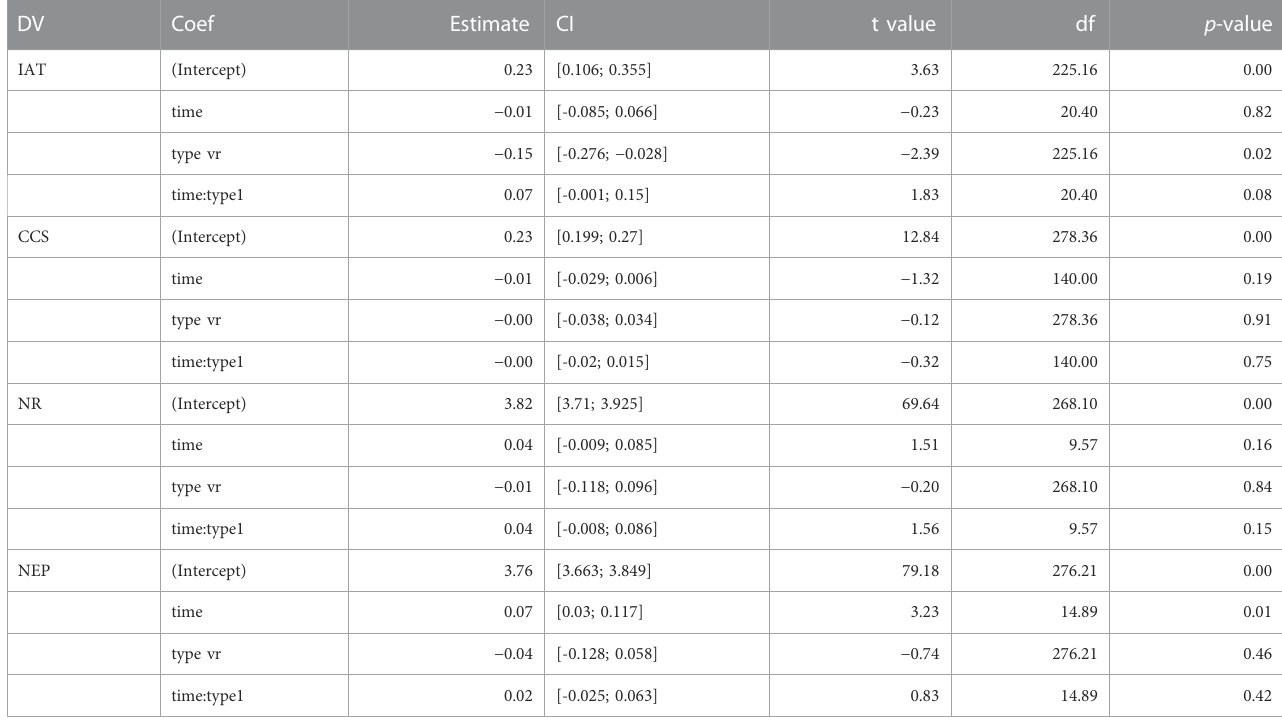
TABLE 2 Models comparing VR to control conditions. Type is deviation coded, the coef fi cient type vr represents the difference between the VR condition compared to the average value at the fi rst measurement. DV Coef Estimate CI t